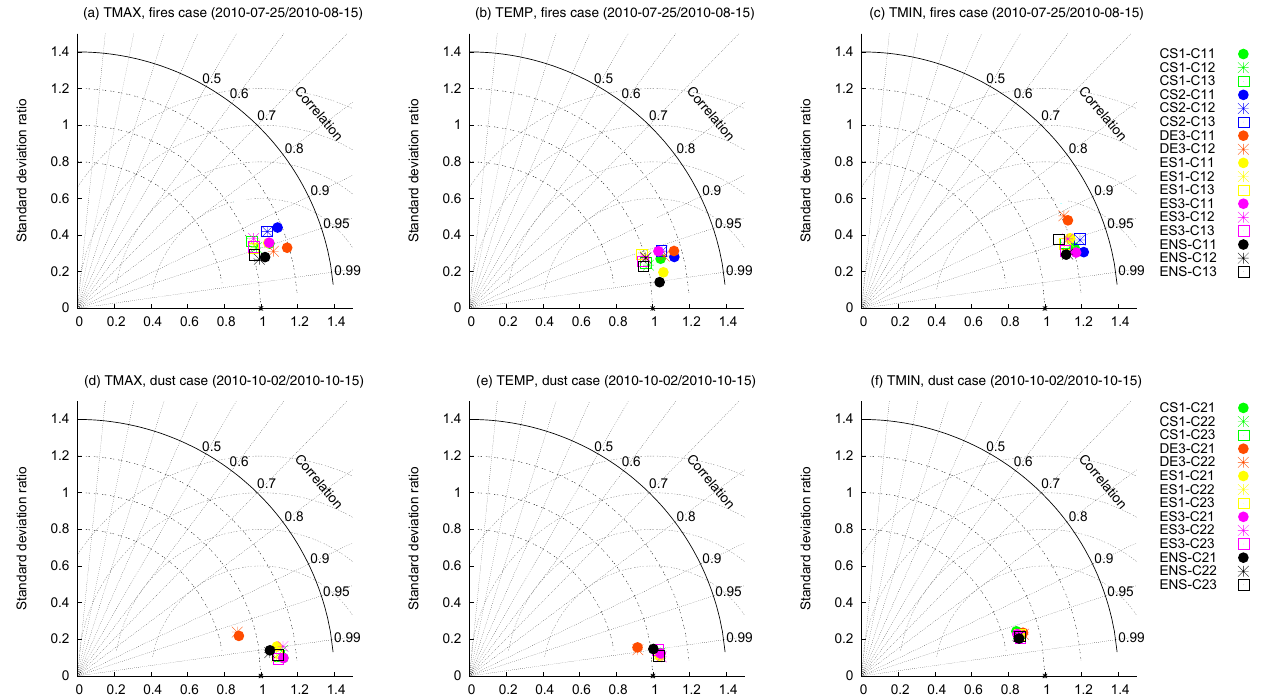
Figure 11. Taylor diagrams for ( a, d ) maximum temperature, ( b, e ) mean temperature and ( c, f ) minimum temperature for the simulations included in the analysis. Panels (a–c) represent the Taylor diagrams for the fire episode, while panels (d–f) stands for the dust episode. The cases included are no radiative feedbacks (filled circle), ARI (asterisk) and ARI + ACI (empty squares). Each configuration is shown in a different color: CS1 (green), CS2 (dark blue), DE3 (red), ES1 (yellow), ES3 (pink) and ENS